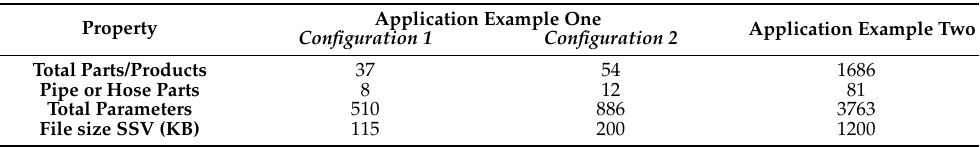
Table 5. Summary of the two application example SSV files exported from the respective geome- try